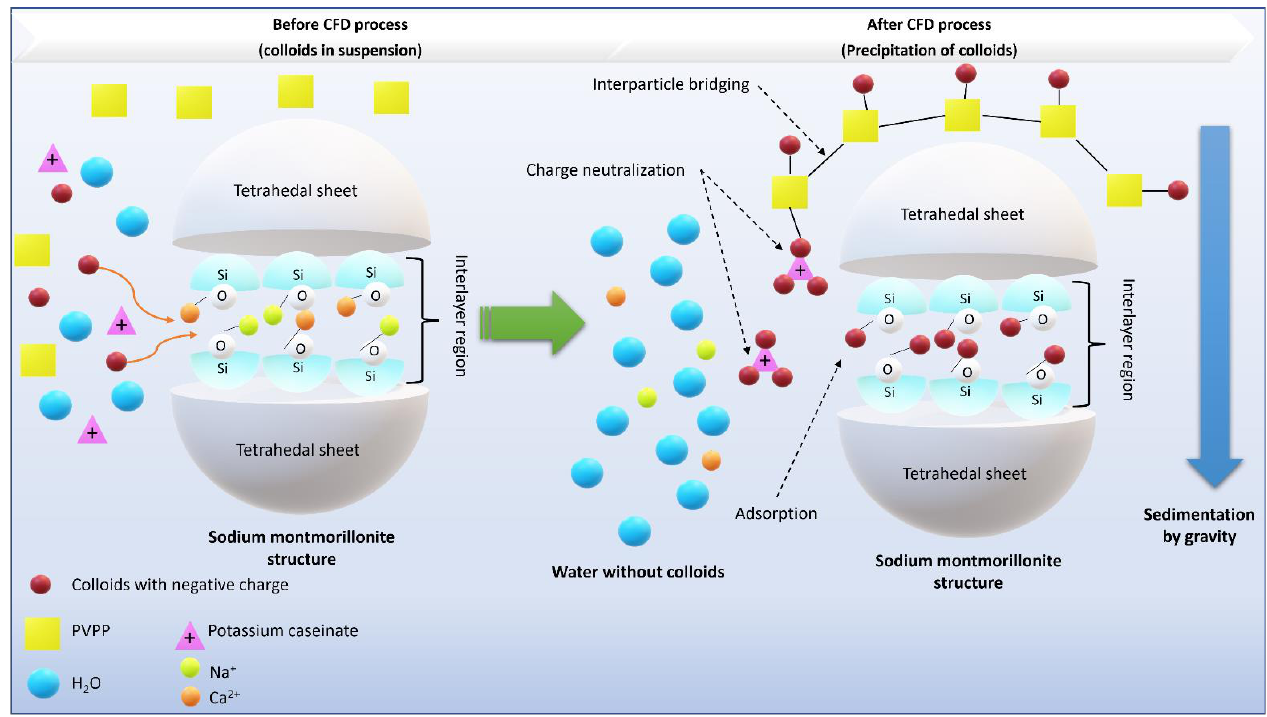
Figure 4. Mechanism of colloid removal by activated sodium bentonite, potassium caseinate and PVPP.